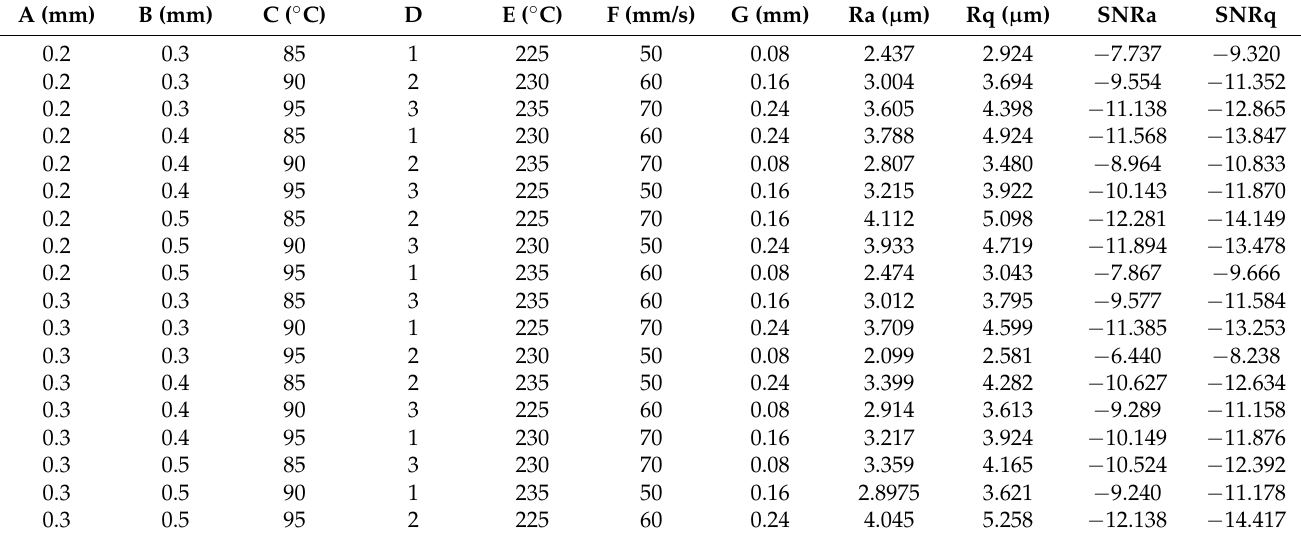
Table 5. Experimental design, results, and their computed S/N ratios for ABS polymer.